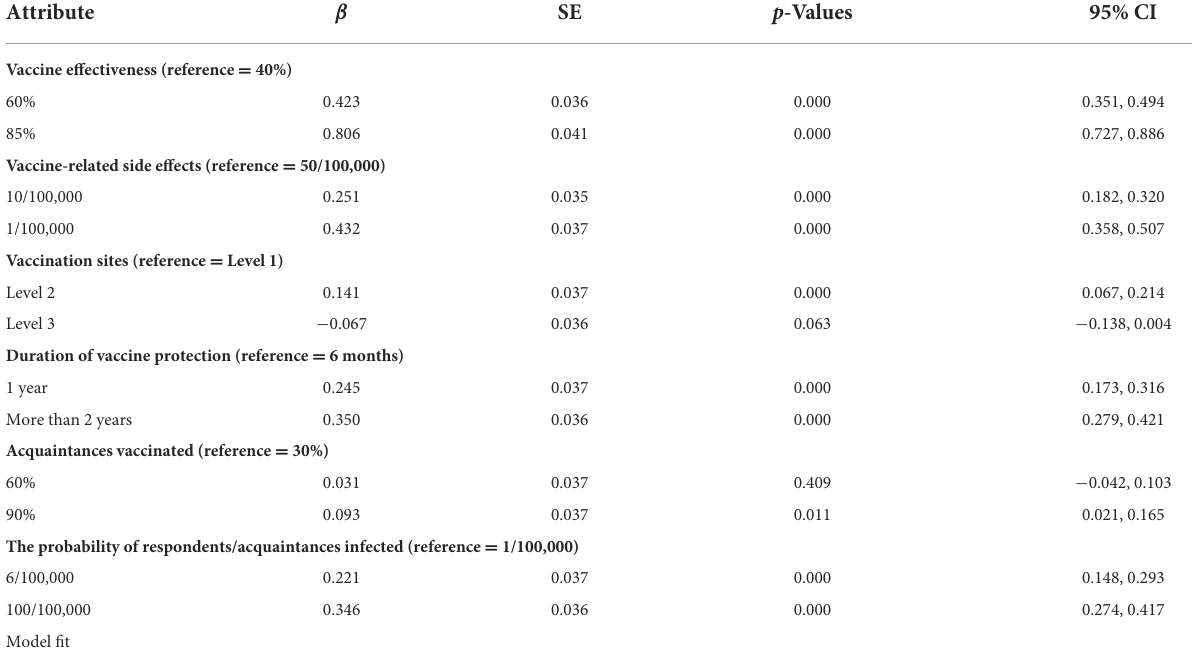
TABLE 4 Conditional logit model of respondent